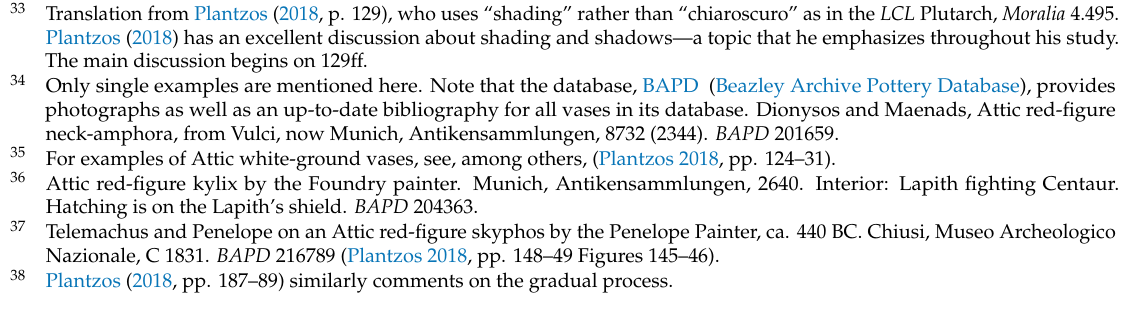
Figure 5. Frigidarium, House of the Cryptoporticus, Pompeii. Source: King’s Visualisation Lab at King’s College London, The Skenographia Project: h ttp://www.kvl.cch.kcl.ac.uk/skeno01.html. Finally, linear perspective is complex. It took approximately one hundred years in the Renaissance for artists to understand more or less how it worked. Classical painters spent a similar amount of time in refining their depictions of shading and shadows. Yet, classical scholars posit linear